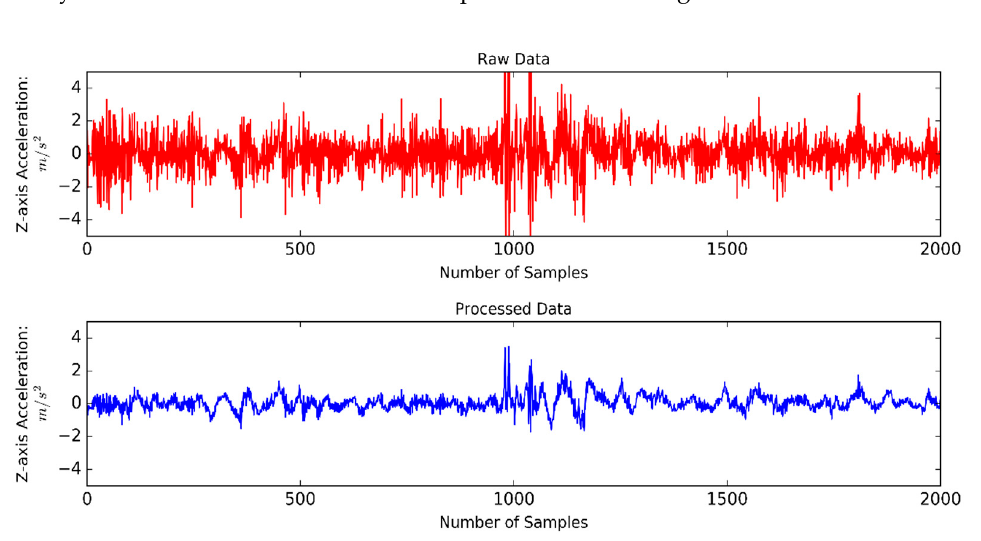
Figure 3. Comparison between raw data and processed data.